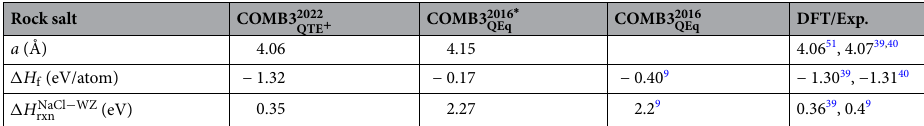
Table 4. Rock salt AlN properties obtained with COMB3 2022 COMB3 2016 QEq AlN publication, DFT, and experimental